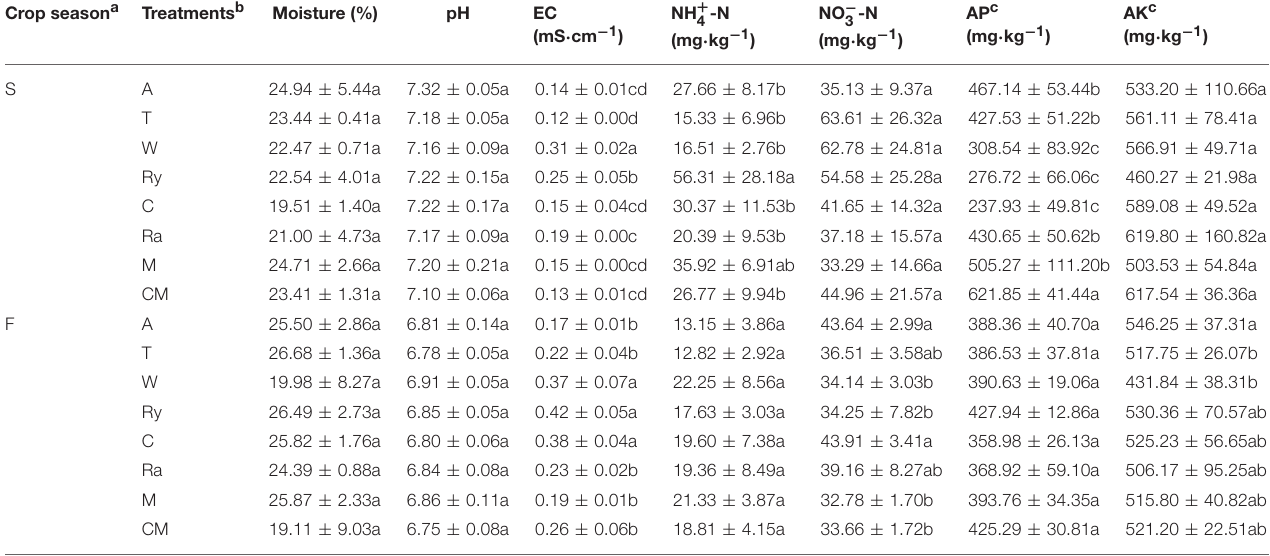
TABLE 1 | Effects of different crop modes on soil chemical properties at two sampling times in a black soil. Crop season a Treatments b